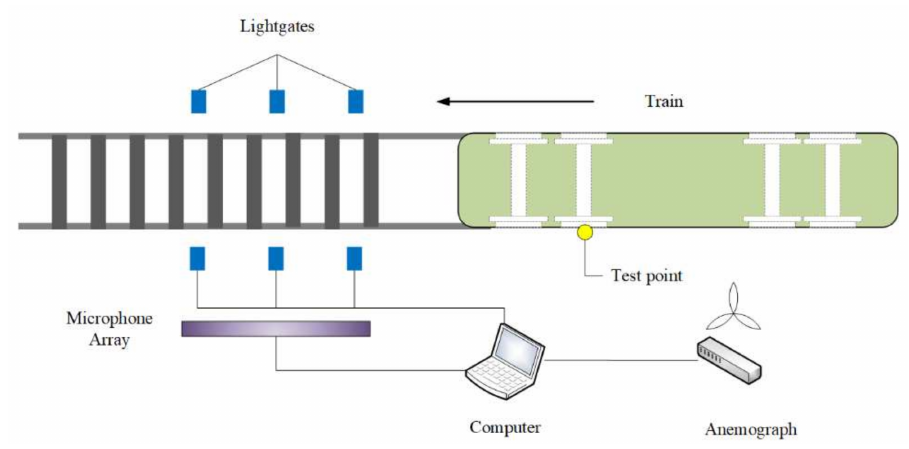
Figure 8. Schematic diagram of the wayside acoustic detection system. Table 3. Partial applied acoustic features in the